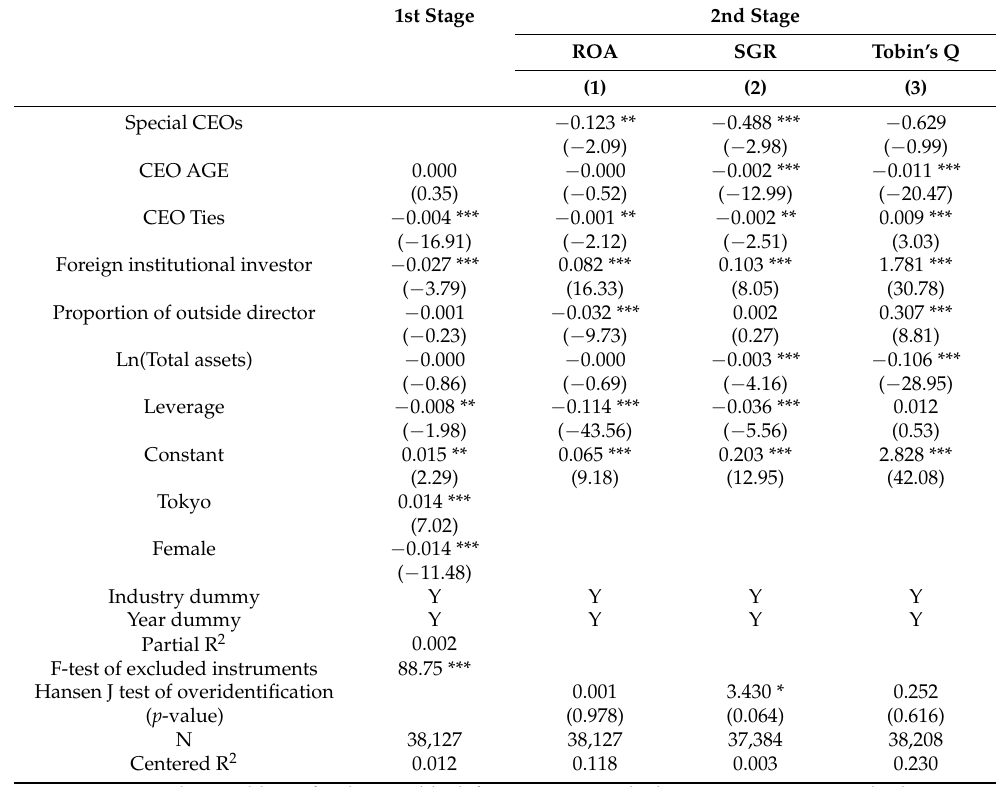
Table 4. Instrumental variable regression